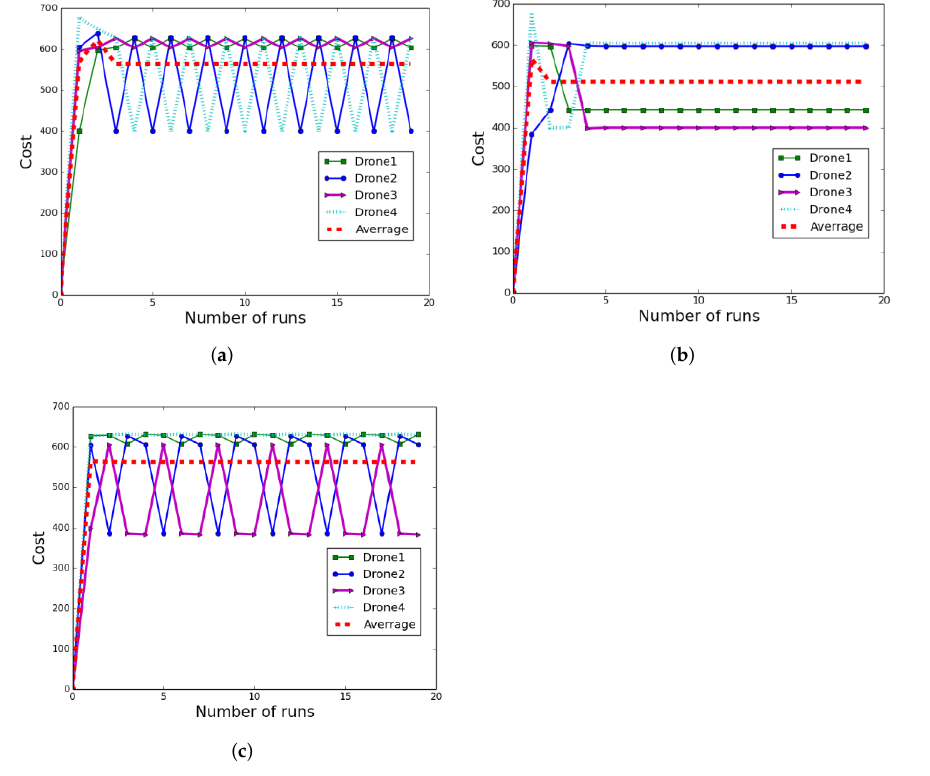
Figure 7. Impact of speed distribution. ( a ) Cost at the same speed; ( b ) cost at the same speed; ( c ) cost related to a different speed